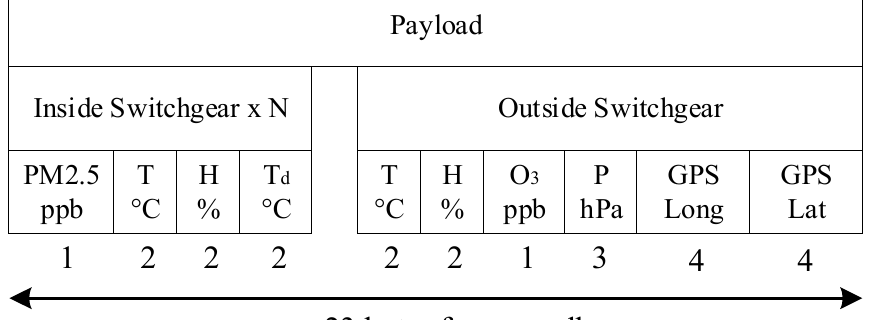
Figure 9. Communication flowchart proposal for microclimate monitoring in LV/MV switchgear . In the next section, it is briefly described data transmission between devices-server, devices-cloud platform or between IoT devices. For our scenario, only two transmission protocols are used, named ModBus and MQTT (Message Queuing Telemetry Transport). ModBus protocol technology in our proposed architecture is used for connecting the LV/MV switchgear sensors to the acquisition system. There are currently a lot of sensors on the market using the ModBus protocol and open-source software that includes a rich palette of development languages such as: C, Java, Python, Node.js and Go. MQTT is a lightweight publish/subscribe messaging protocol that can be used for M2M IoT (Machine to Machine) communications [27]. The main characteristics of MQTT are low power consumption, small code size, minimized data packet size, and the possi- bility to distribute different packets to multiple applications almost at the same time. Any network-wired or wireless device that provides a bi-directional connection can support MQTT. This MQTT protocol was specifically designed for high latency networks or low bandwidth resource-constrained devices. The monitoring interface was designed to be available in two places: locally (SW mi- croSCADA PLC) and remotely on more than two separate servers and using information security protocols.